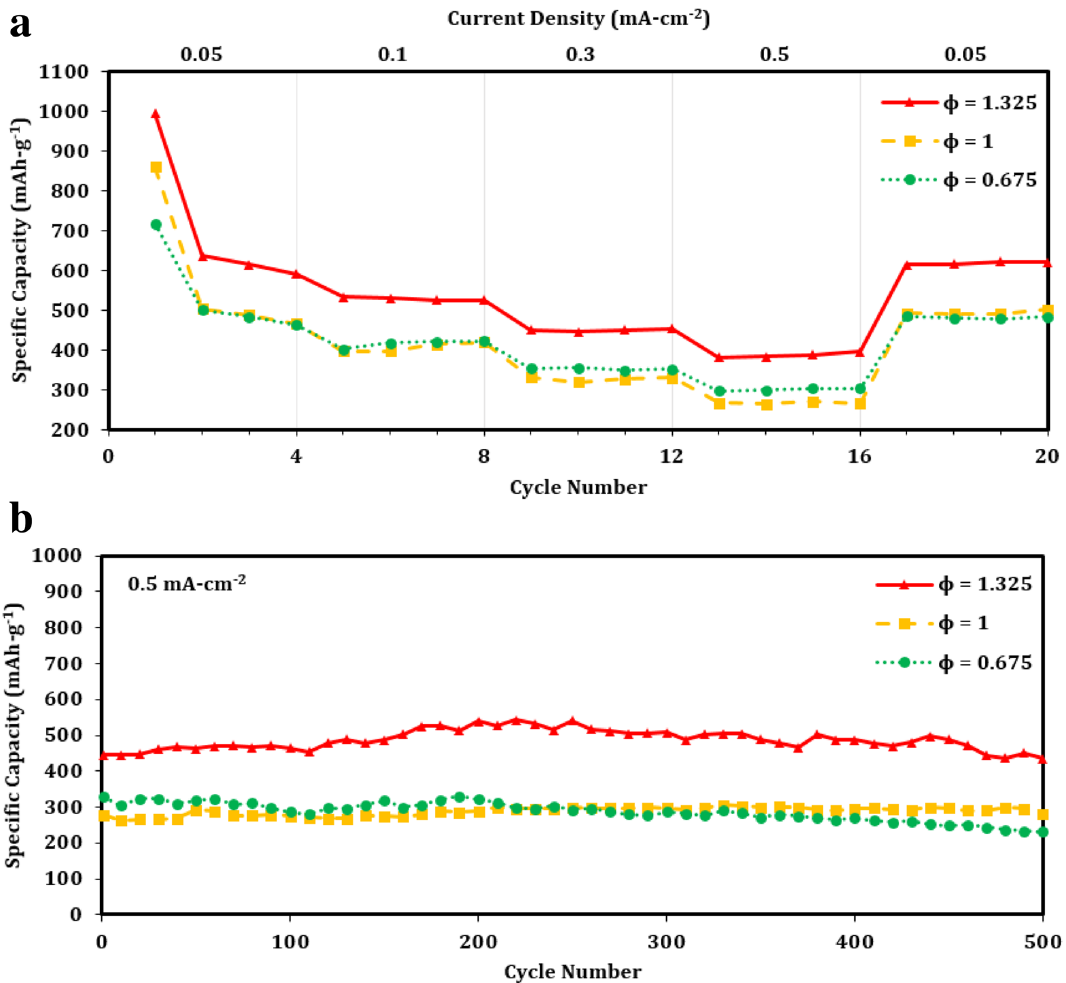
Figure 7. Electrochemical discharge performance of porous CaFe 2 O 4 samples: ( a ) rate performance and ( b ) subsequent long-term cycling performance of pCFO synthesized at increasing ϕ and calcined at 900 °C; ( c ) rate performance and (d) subsequent long-term cycling performance of pCFO synthesized at ϕ = 1.325 and calcined at different